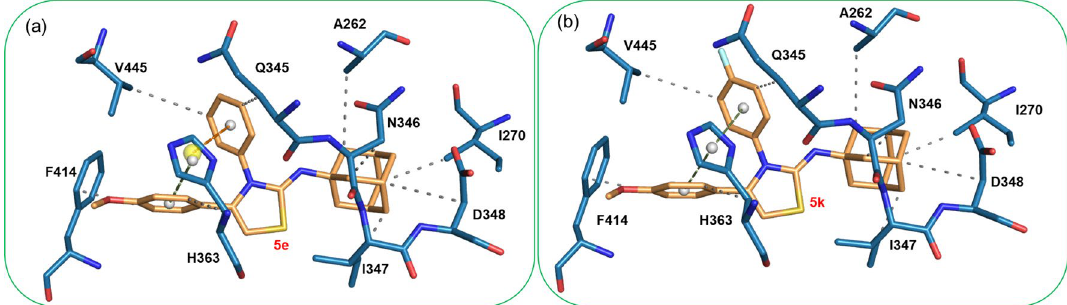
Figure 8. Interactions between SIRT1 ( a ) compound 5e and ( b ) compound 5k . Small spheres represent the centroid of the respective